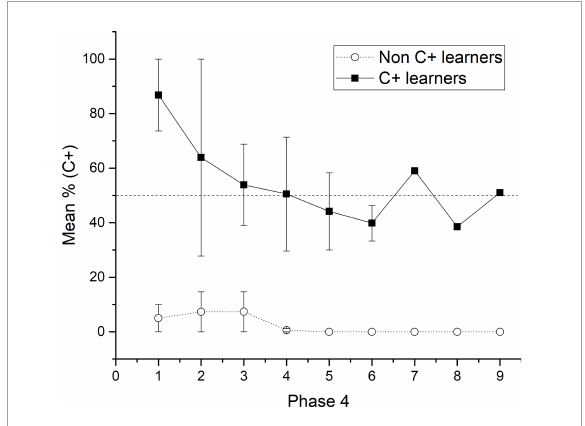
FIGURE4 Mean percentage (SEM ± ) of C + responses for C + learners and non C + learners across the nine sessions of phase